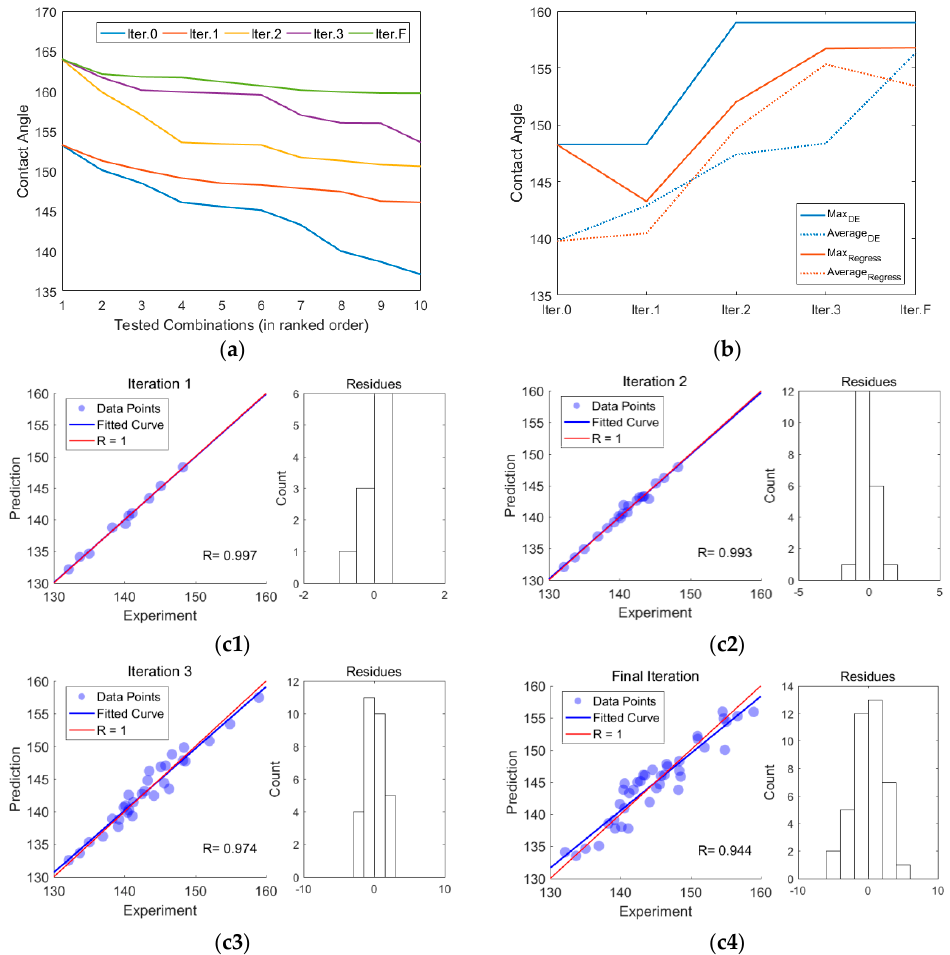
Figure 2. Optimization of contact angle in five rounds of experiments. ( a ) Best 10 combinations found in five rounds of experiments are represented by five colored lines. ( b ) Contact angles of the best combination and average performance by regression and differential evolution (DE) separately in each round of experiments. ( c ) Correlation coefficient and distribution of SSE (sum of squares for error) for the regression model used to predict each iteration.